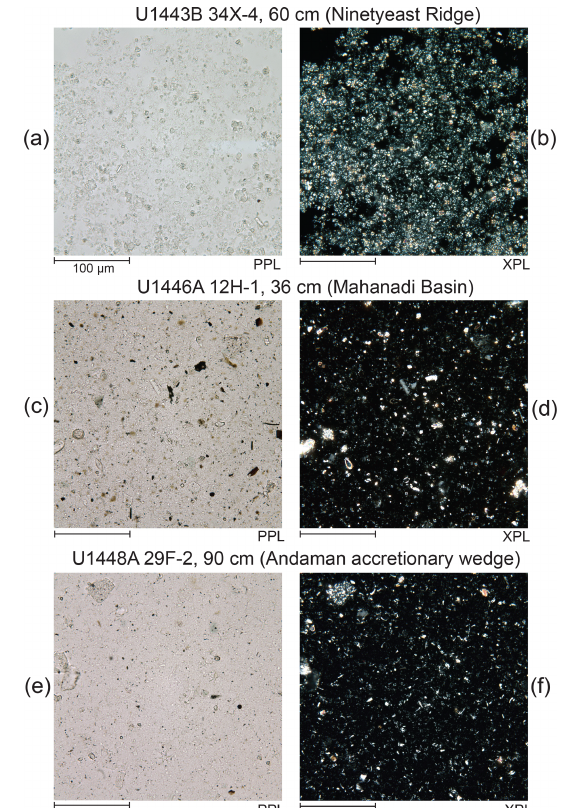
Figure 3. Example photomicrographs of smear slides described during IODP Expedition 353. (a, b) Clayey nannofossil chalk with authigenic carbonate from Site U1443 (Ninetyeast Ridge). (c, d) Nannofossil-rich clay with foraminifers from Site U1446 (Mahanadi Basin). (e, f) Nannofossil-rich clay from Site U1448 (Andaman accretionary wedge). Photomicrographs are shown for both plane-polarized light (PPL; a, c, e ) and cross-polarized light (XPL; b, d, f ). The scale bar is 100µm in each